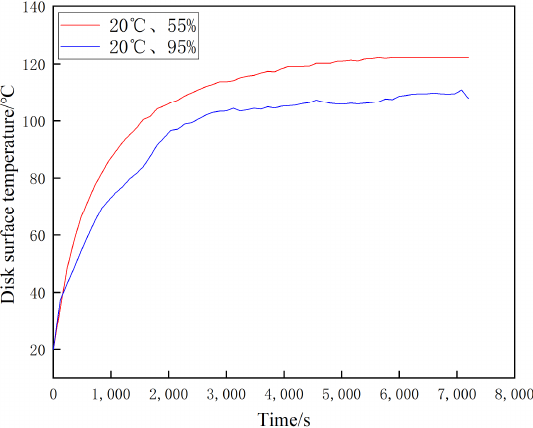
◦ C under different ambient humidities.